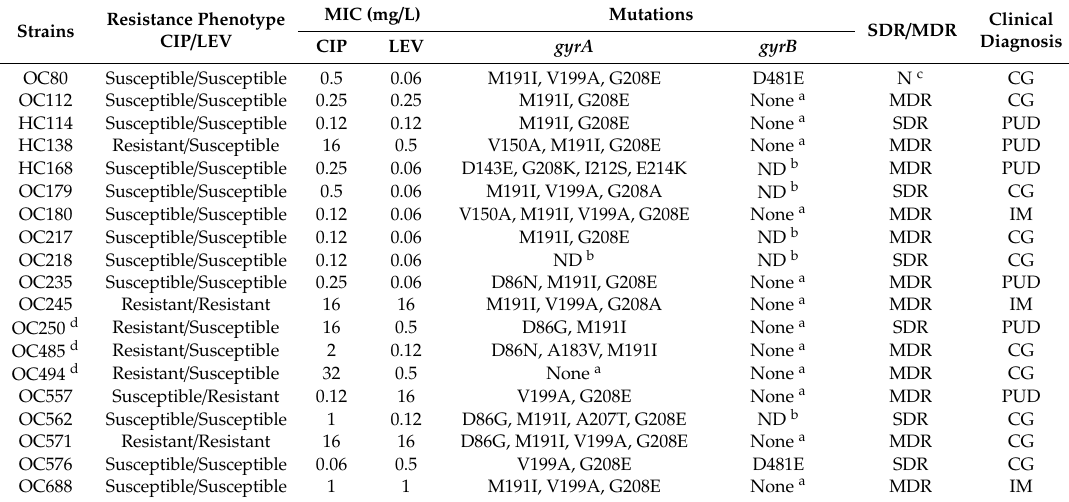
Table 6. Mutations in gyrA and gyrB genes involved in fluoroquinolone resistance among H. pylori isolates used in this